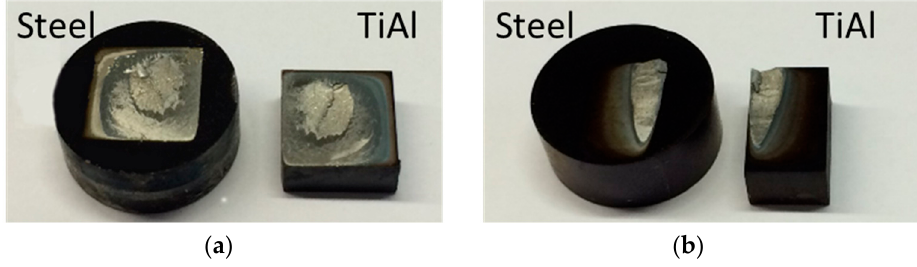
Figure 7. Macroscopic images of fracture surfaces of shear test specimens of the joints produced at 800 °C using Ni/Ti multilayers with: ( a ) 30 nm and ( b ) 60 nm of bilayer thickness.